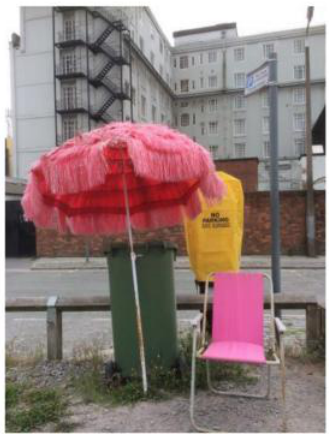
Figure 16. Parking bay suspended on Car Park